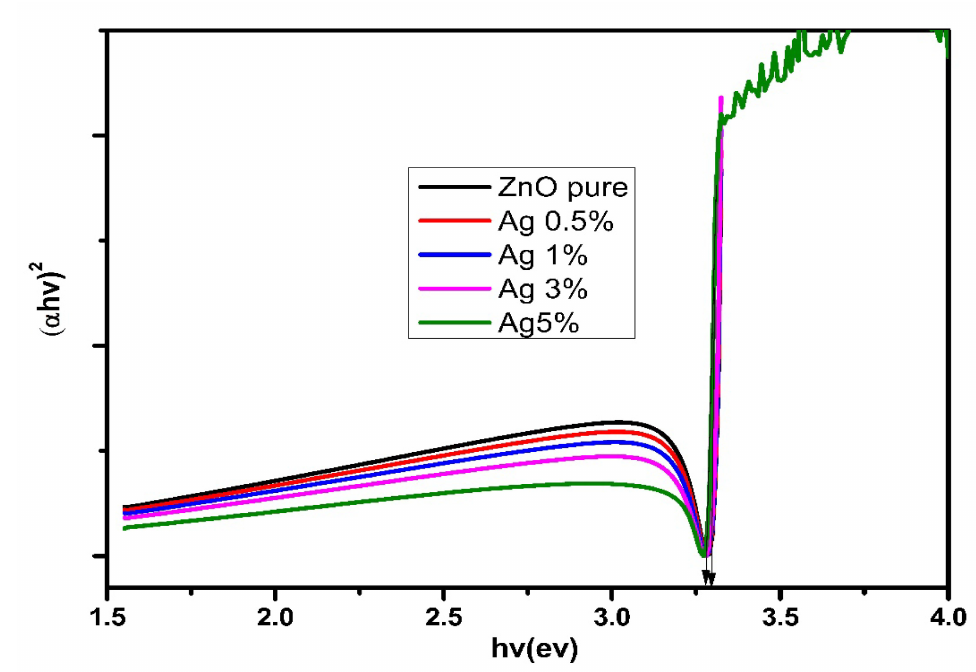
Figure 7. The bandgap for undoped ZnO and Ag-doped ZnO thin